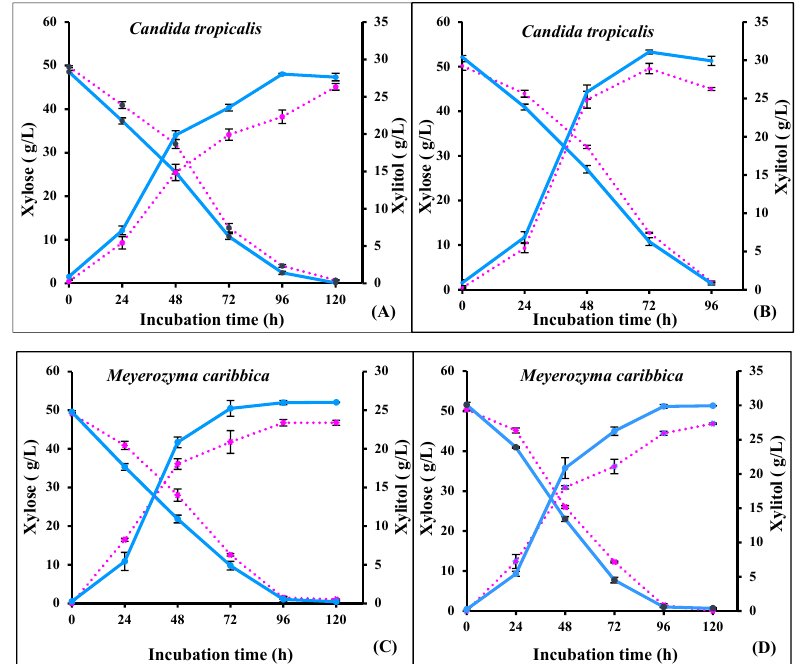
Figure 4. Fermentation profile of un-adapted (dotted line) and adapted (solid line) strains of C. trop- icalis in ( A ) non-detoxified rice straw hydrolysate, and ( B ) detoxified rice straw hydrolysate; and M. caribbica in ( C ) non-detoxified rice straw hydrolysate, and ( D ) detoxified rice straw hydrolysate. A comparative analysis of the performance of the yeasts for xylitol production on rice straw and other biomasses is presented in Table 3. The analysis suggests the higher po- tential of the identified yeasts for xylitol production, at least from rice straw biomass. Table 3. Comparison of xylitol production by different strains.